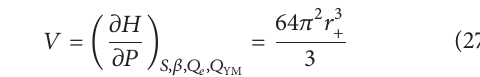
Figure 1: Isobaric plots for 𝑄 top to bottom, the pressures are, respectively, 𝑃 = 1.2𝑃 𝑐 (dotted), 𝑃 = 𝑃 𝑐 (dashed), and 𝑃 = 0.8𝑃 𝑐 (solid). is satisfied,